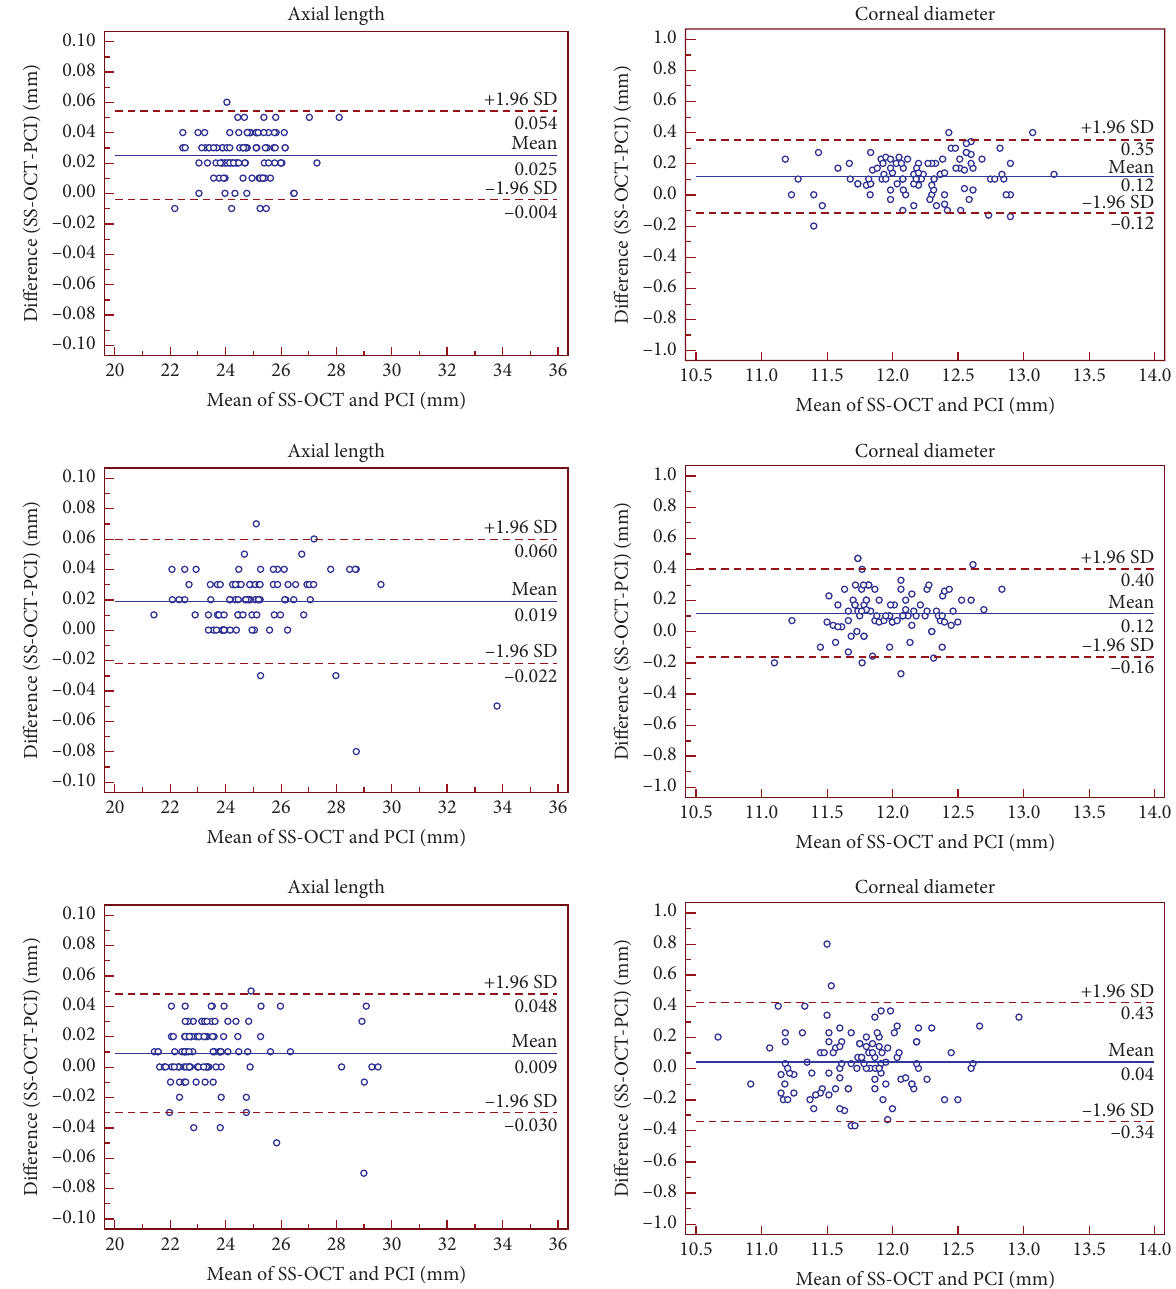
Figure 2: Bland–Altman plot of the axial length measurements and the corneal diameter measurements using IOLMaster 700 swept-source optical coherence tomography against IOLMaster partial coherence interferometry in children (in the first row), normal subjects (in the second row), and cataract patients (in the third row). The solid line represents the mean difference. The dotted lines on the side represent the upper and lower 95%